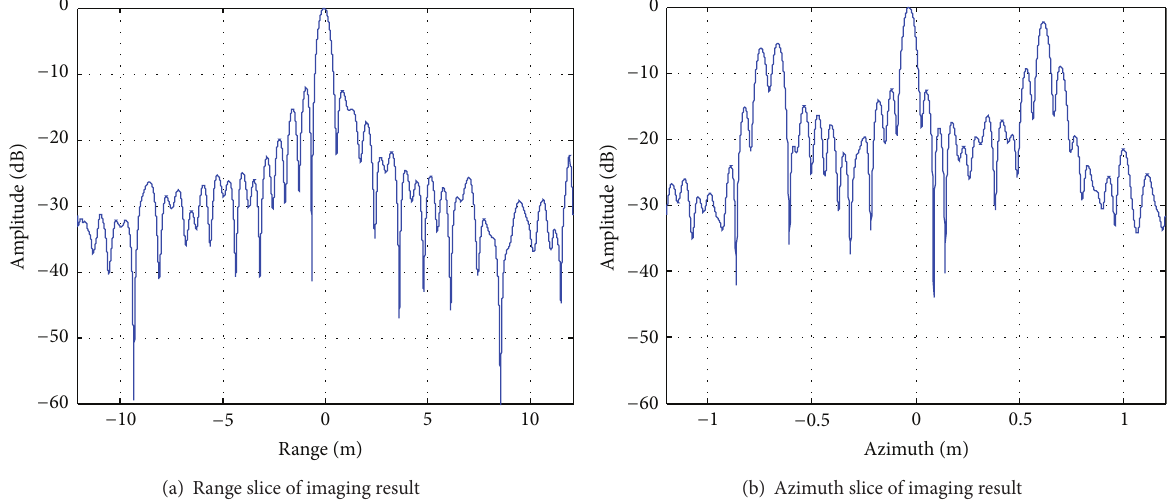
Figure 10: Traditional SISO SAR imaging